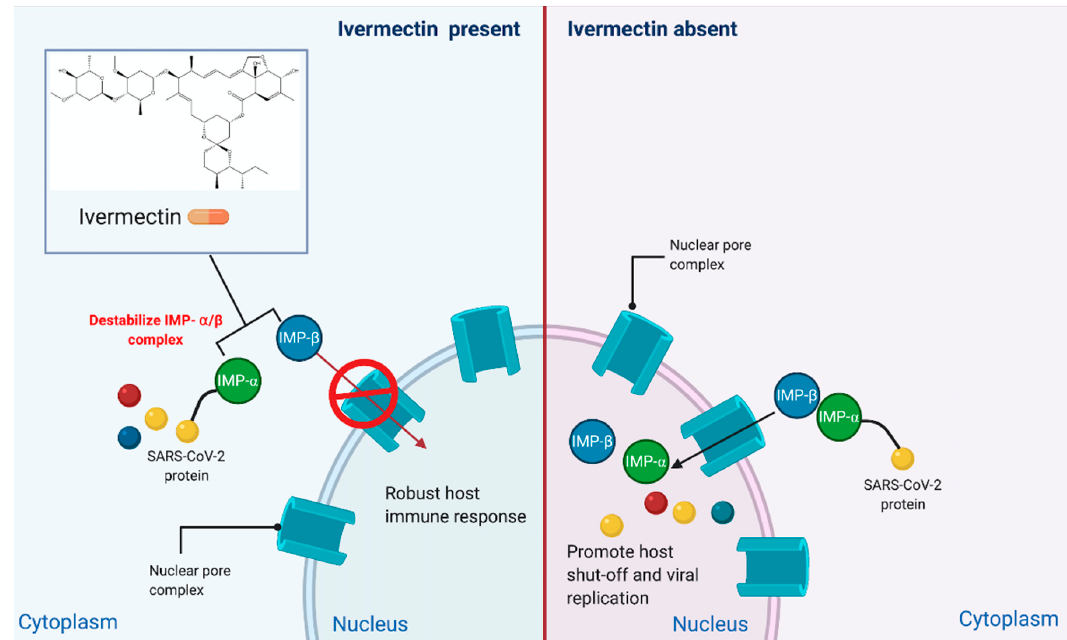
Figure 1. Ivermectin inhibits SARS-CoV-2 protein transport to the nucleus.